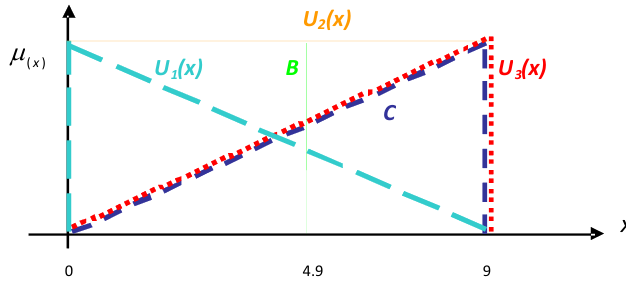
Fig. 6. Comparison of fuzzy numbers B=(4.9,4.9,4.9) and C=(0,9,9) based on descending, constant and ascending linear utility